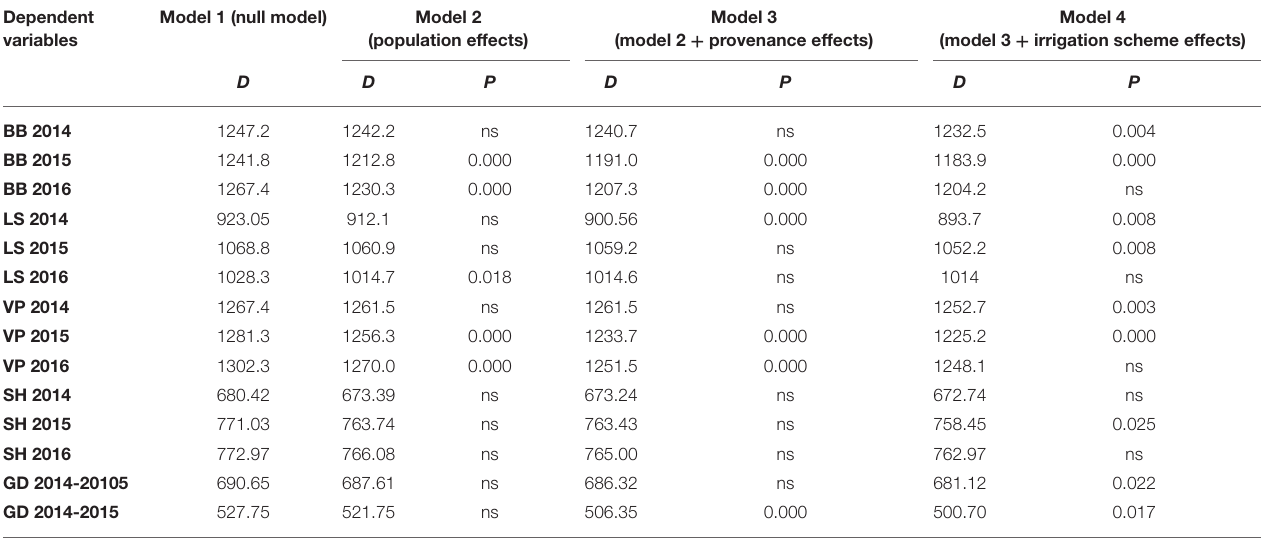
TABLE 5 | Model comparisons of the HLM models for the complete data via LRT (D: likelihood ratio statistic; P: p-value of the statistical significance of LRT test). Dependent